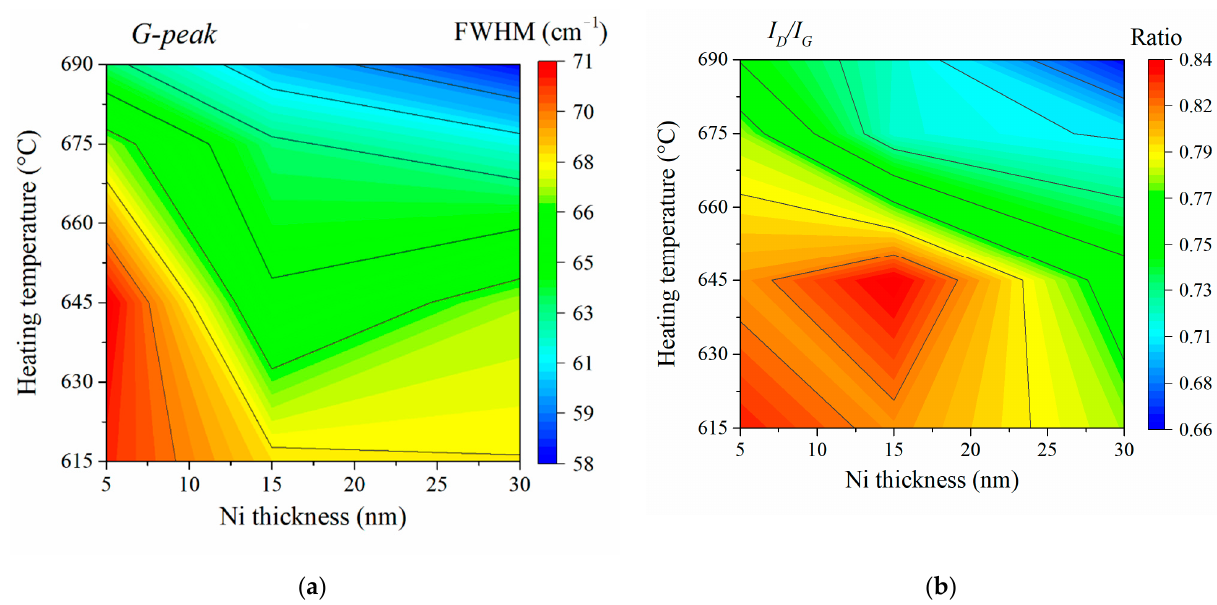
Figure 3. Maps of the FWHM distribution of the G-peak ( a ) and the ratio of the intensities of the D- and G- peaks I D /I G ( b ) of the Raman spectra of CNT arrays versus the growth temperature and the thickness of the catalytic layer.